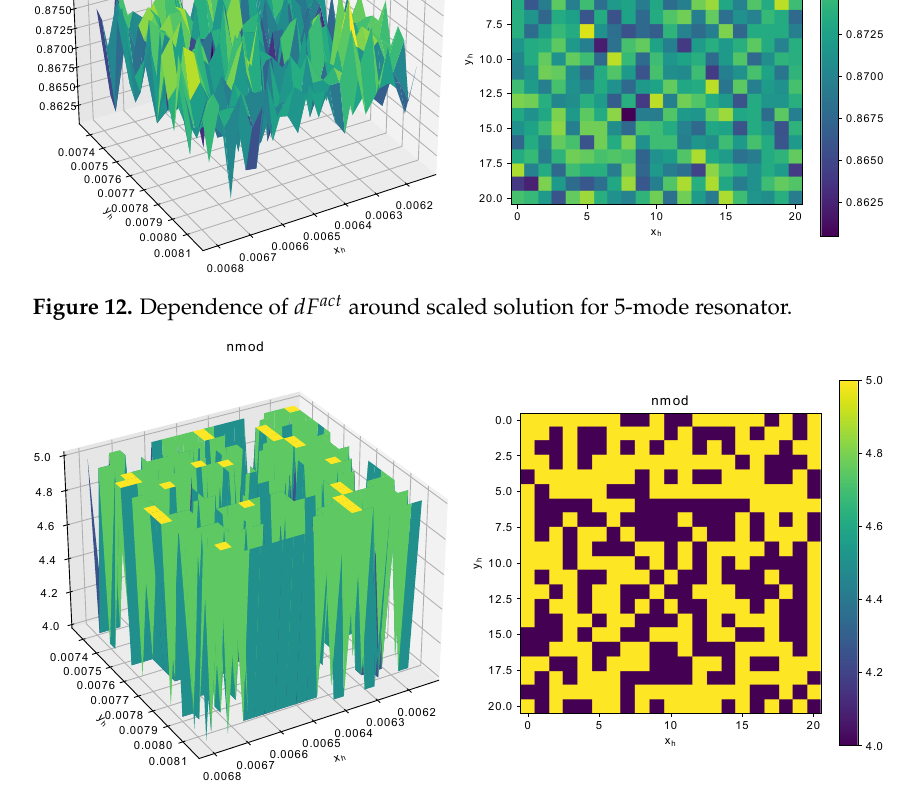
Figure 13. Dependence of number of modes around scaled solution for 5-mode